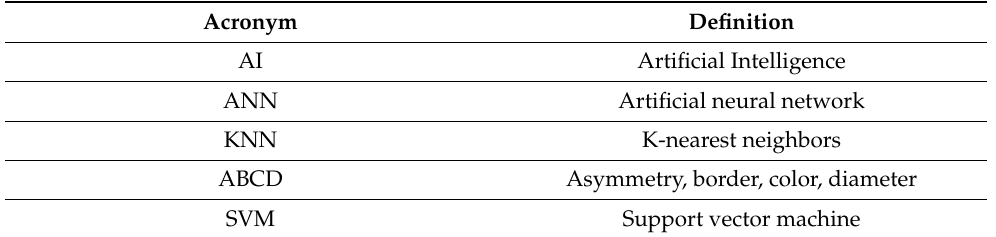
Table A1. List of abbreviations used in this manuscript along with their full